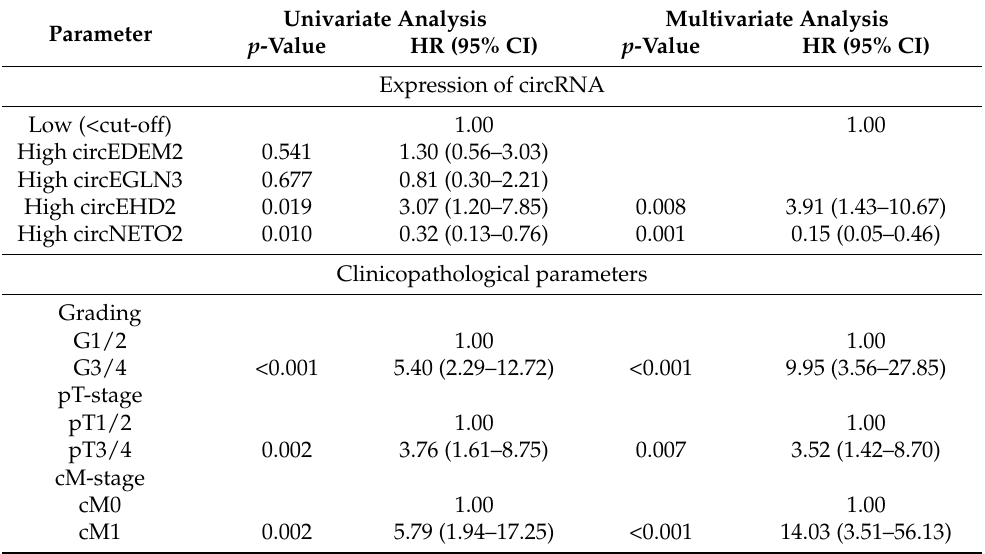
Table 4. Uni- and multivariate Cox regression analysis for overall